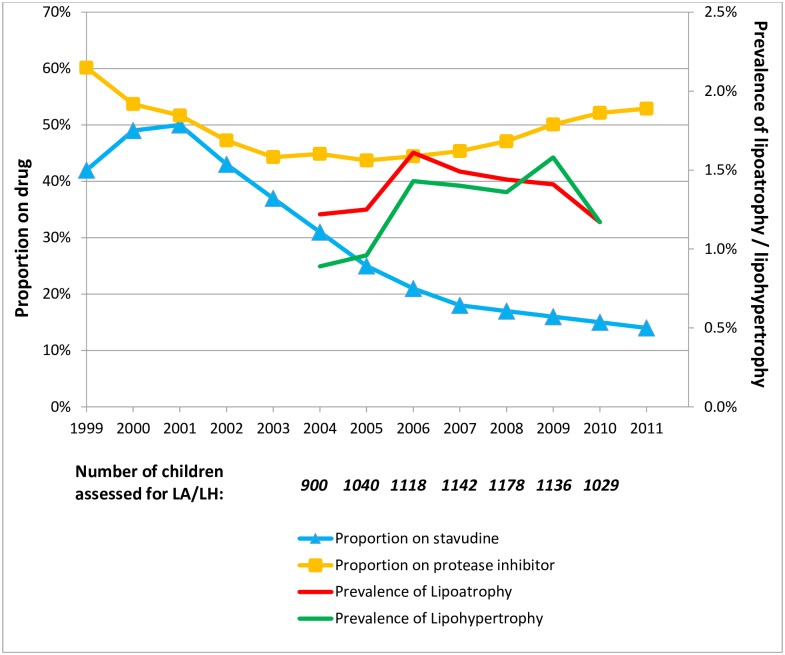
Prevalence of lipoatrophy (LA) and lipohypertrophy (LH) and proportion of children on stavudine and on protease inhibitors during each calendar year in the UK and Ireland.The denominator for calculation of prevalence in each calendar year is presented below the graph.